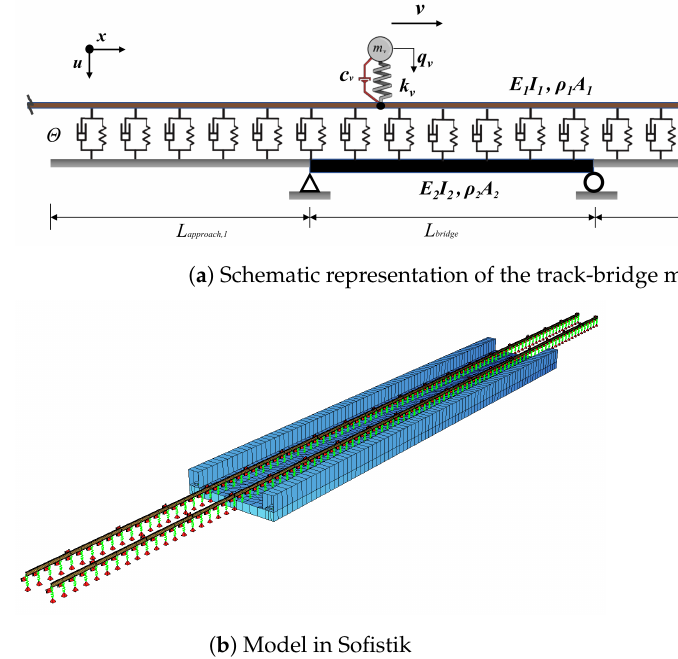
Figure 5. Numerical model of the track-bridge